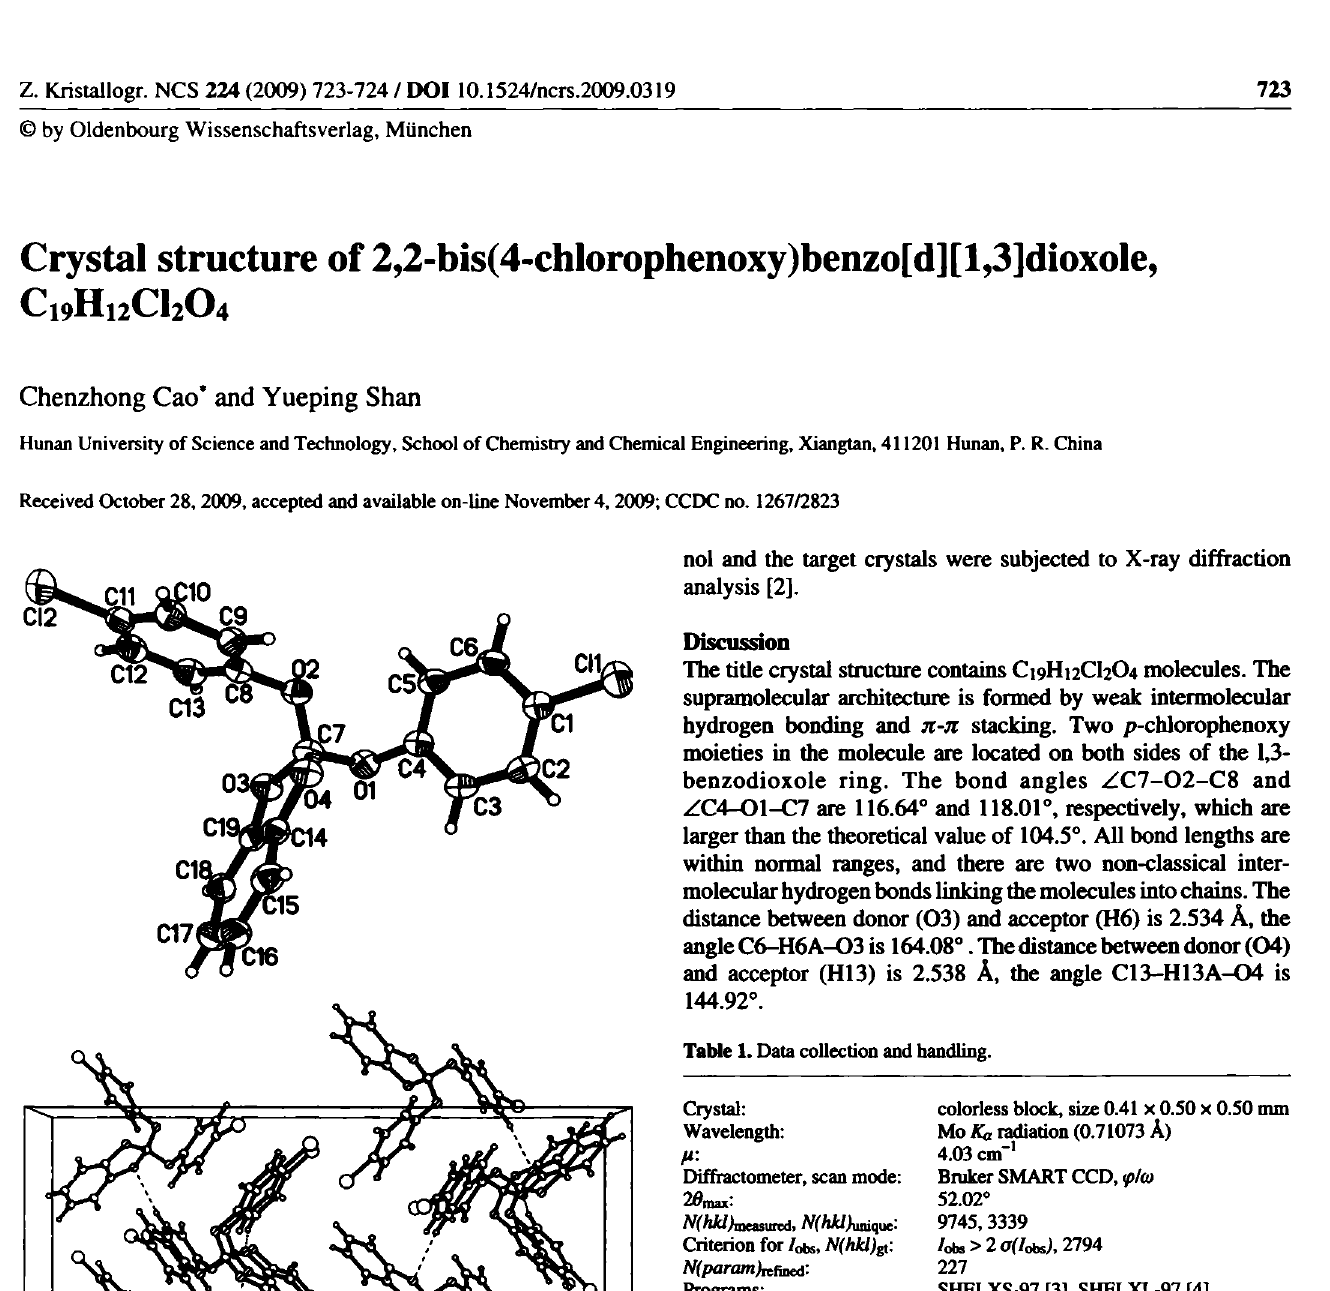
Table 2. Atomic coordinates and displacement parameters (in Ä 2